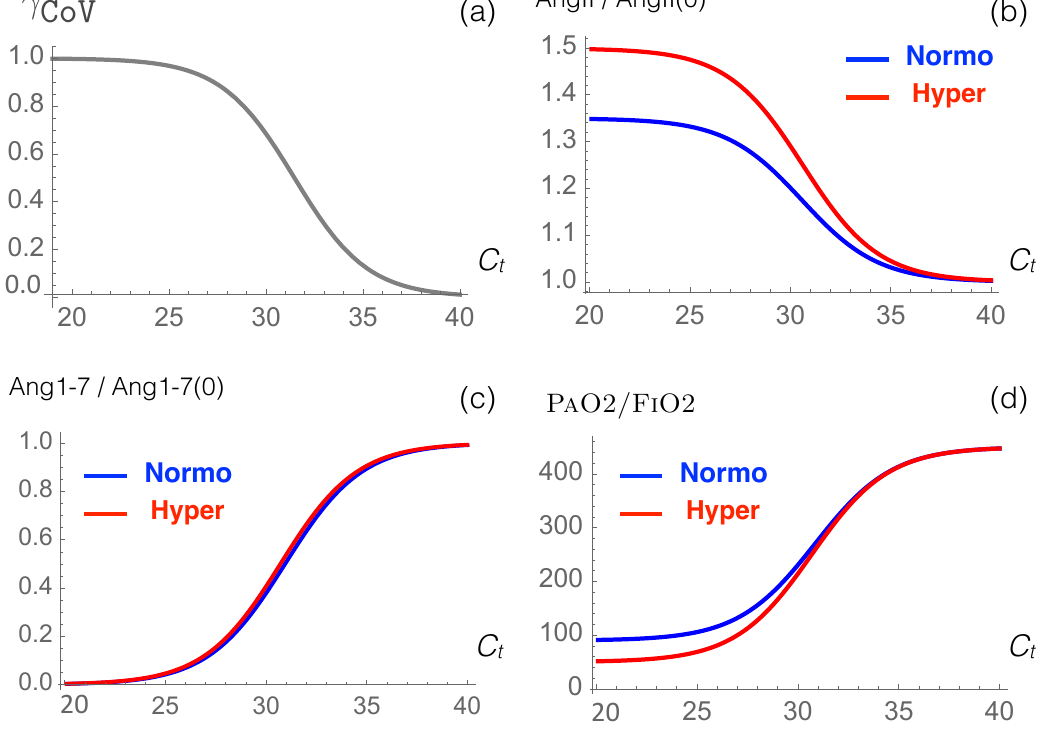
Figure 3. Simulated response of RAS to viral infection. ( a ) The γ CoV function used to model the effect of the infection as a function of C t , the cycle threshold of the virus. ( b – d ) Predictions obtained from our model for the normalized levels of AngII and Ang1-7 and for the physiological P A O2/F I O2 value, as a function of C t , for normotensive (blue) and hypertensive (red)